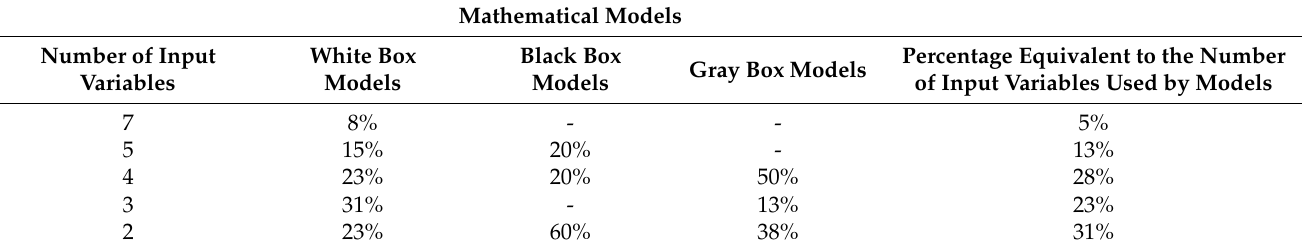
Table 4. Reported input variables in mathematical models for estimating photosynthesis. The table shows the representation of the percentage equivalent to the number of input variables used by the reviewed mathematical models for white, black, or gray box